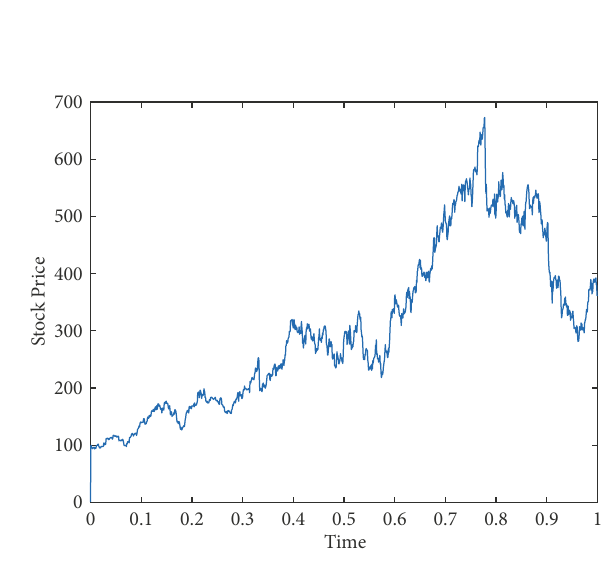
Figure 2: Simulation of stock price